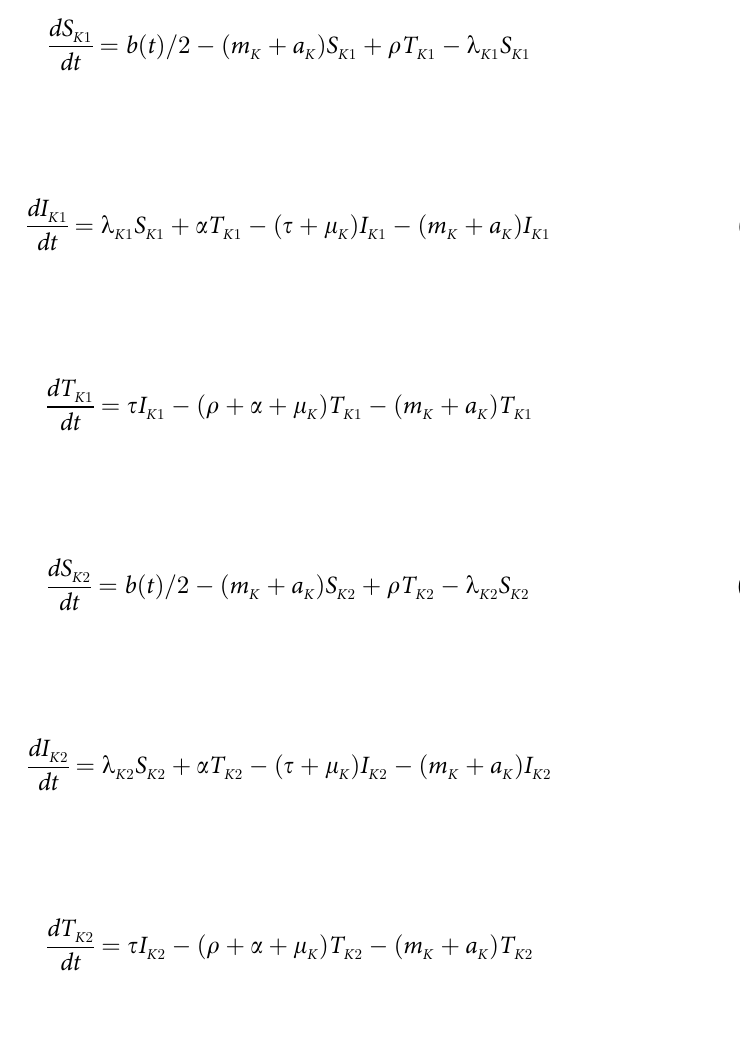
Susceptible young males and females can die of natural cause, or age into the adult class. Young males can acquire infection from fight contacts with other youngsters or with adult males, the latter with lower probability. They can also acquire infection from sexual contacts with young and adult females, the former more frequently than the latter. As with the kittens, young infected individuals can die from other causes or from sporotrichosis, or be treated and move to the T classes. Treated animals can abandon treatment and return to the I Y